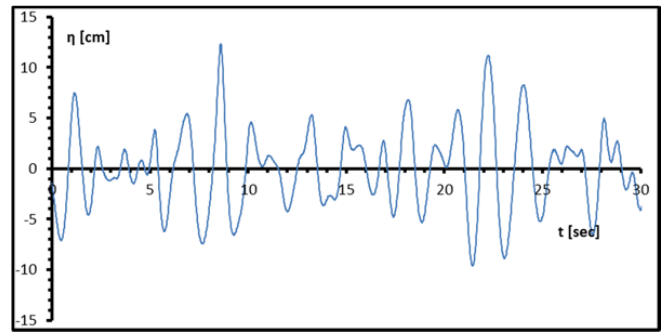
Figure 9. Water elevation η time series for Experiment #6.